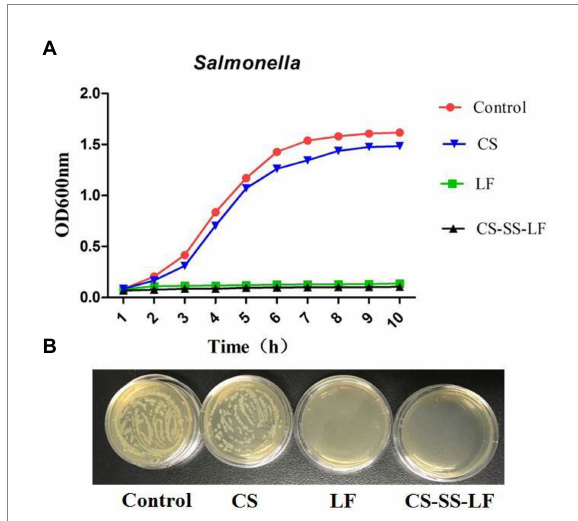
FIGURE 7 (A) The growth curves of Salmonella were determined by culturing bacteria in TSB containing CS-SS-LF micelles (80 μ g/mL, [LF] = 17.2 μ g/mL), CS (80 μ g/mL) or LF (18 μ g/mL). (B) CFU counts of Salmonella (10 h) after 10 6 -fold dilutions.